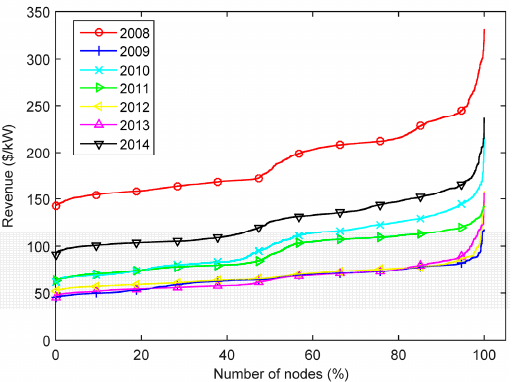
Figure 14. Yearly-based potential arbitrage revenue of a 10 h. ESS with 95% round trip efficiency for RTM in PJM, encompassing 7395 nodes. The abscissa is the percentage of nodes with revenue less than the value given by the ordinate; the values are independently sorted by year.